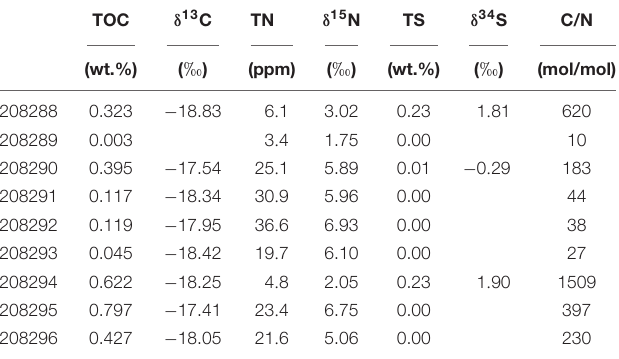
TABLE 2 | Organic carbon, total nitrogen and total sulfur